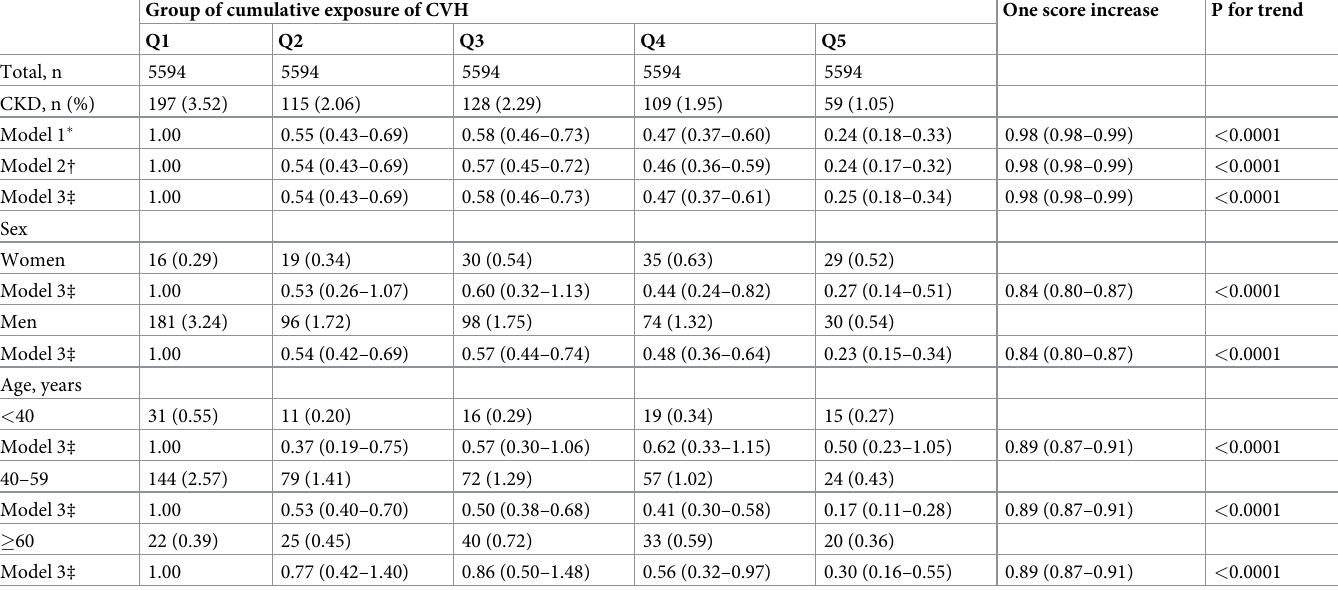
Table 2. Odds ratios and 95% confident intervals of CKD in relation to quintiles of cumulative exposure of CVH. Group of cumulative exposure of